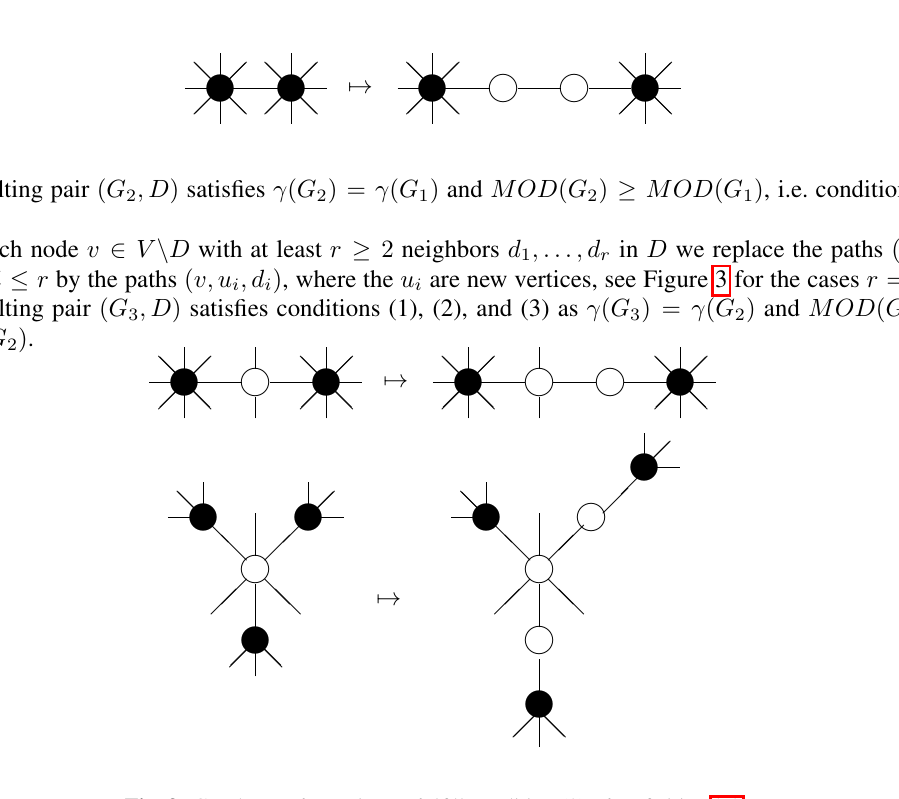
Fig. 3: Graph transformation to fulfill condition (3) of Definition